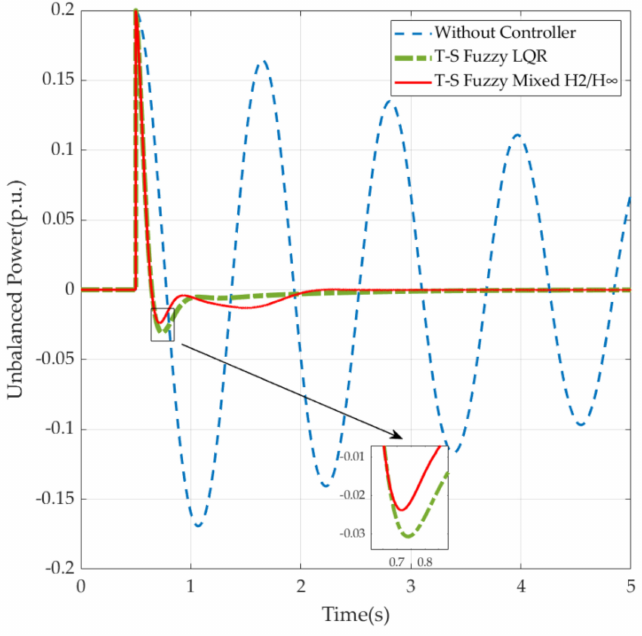
Figure 15. The curve of unbalanced power change during sudden 0.2 (p.u.) load